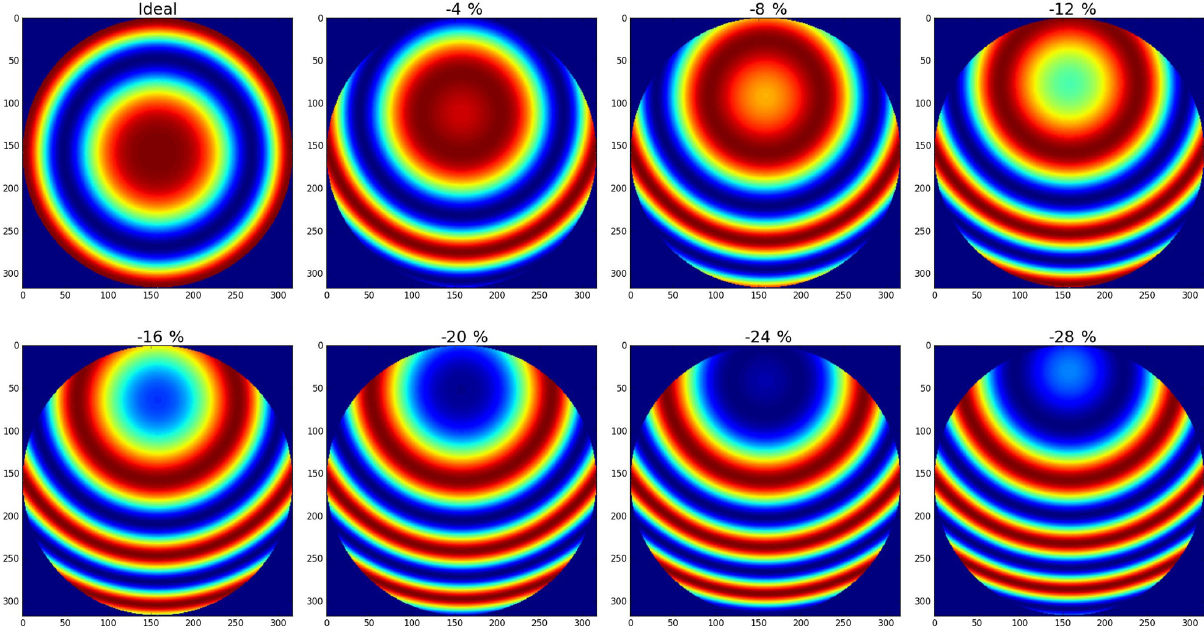
Figure 13. The Haidinger fringes at half-maximum OPD (the maximum misalignment position) for Fig.